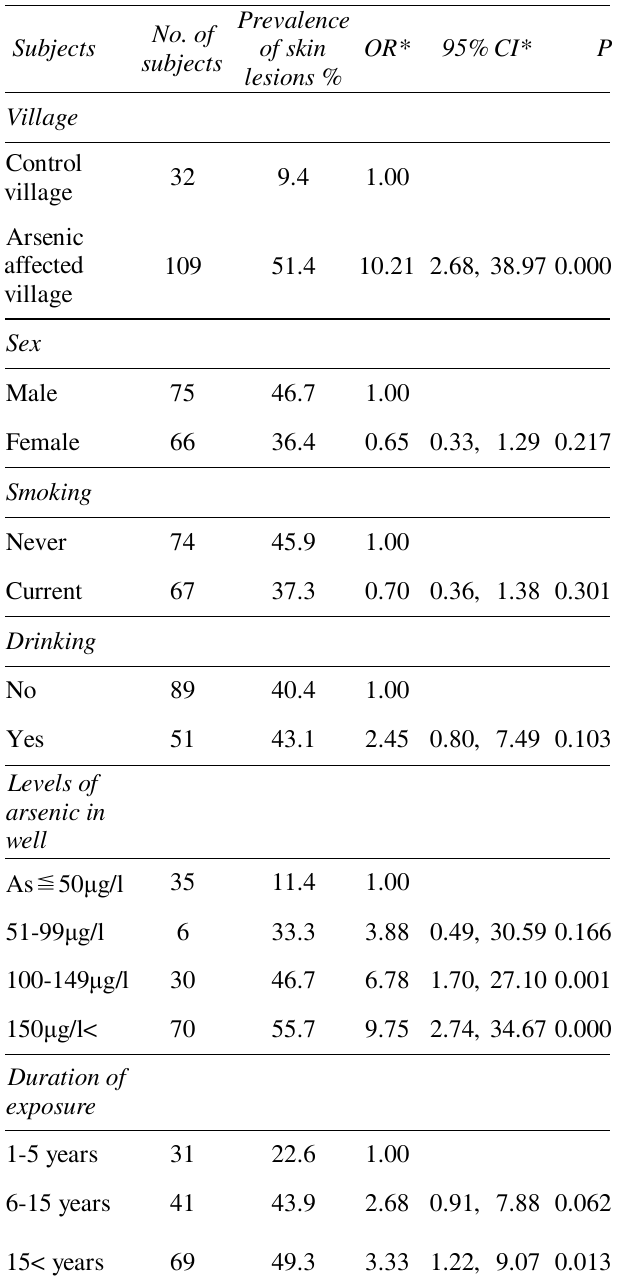
Table 3: The Odds Ratios and 95% Confidence Intervals, from logistic regression analysis, for skin lesions